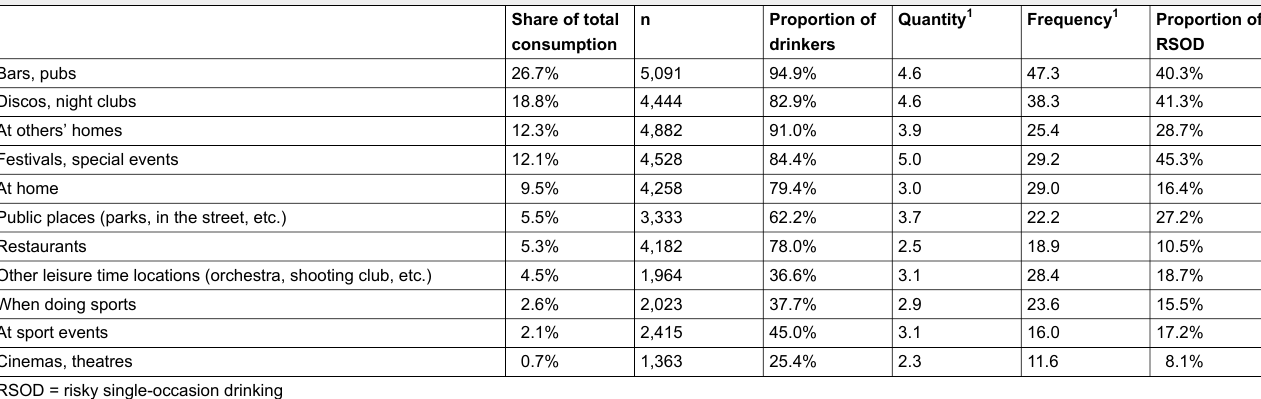
Table 1: Alcohol consumption of those drinking at a given